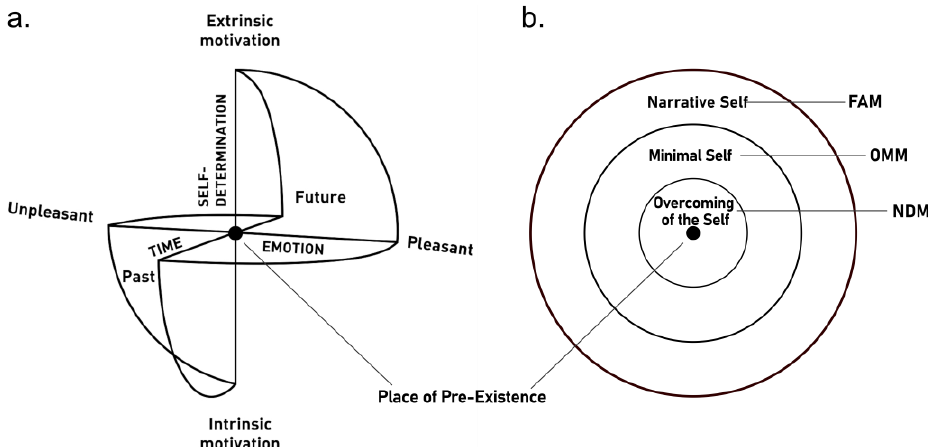
Figure 1. ( a ) Sphere Model of Consciousness (SMC) axes and polarities. ( b ) Layers of the Sphere Model of Consciousness, from the more external to the more internal. Each layer corresponds to one state of the self (narrative self, minimal self, overcoming of the self) and it is associated with a specific type of meditation (focused attention meditation, open monitoring meditation, non-dual meditation). Adapted from Paoletti and Ben-Soussan [6,12]. FAM = focused attention meditation; OMM = open monitoring meditation; NDM = non-dual meditation.